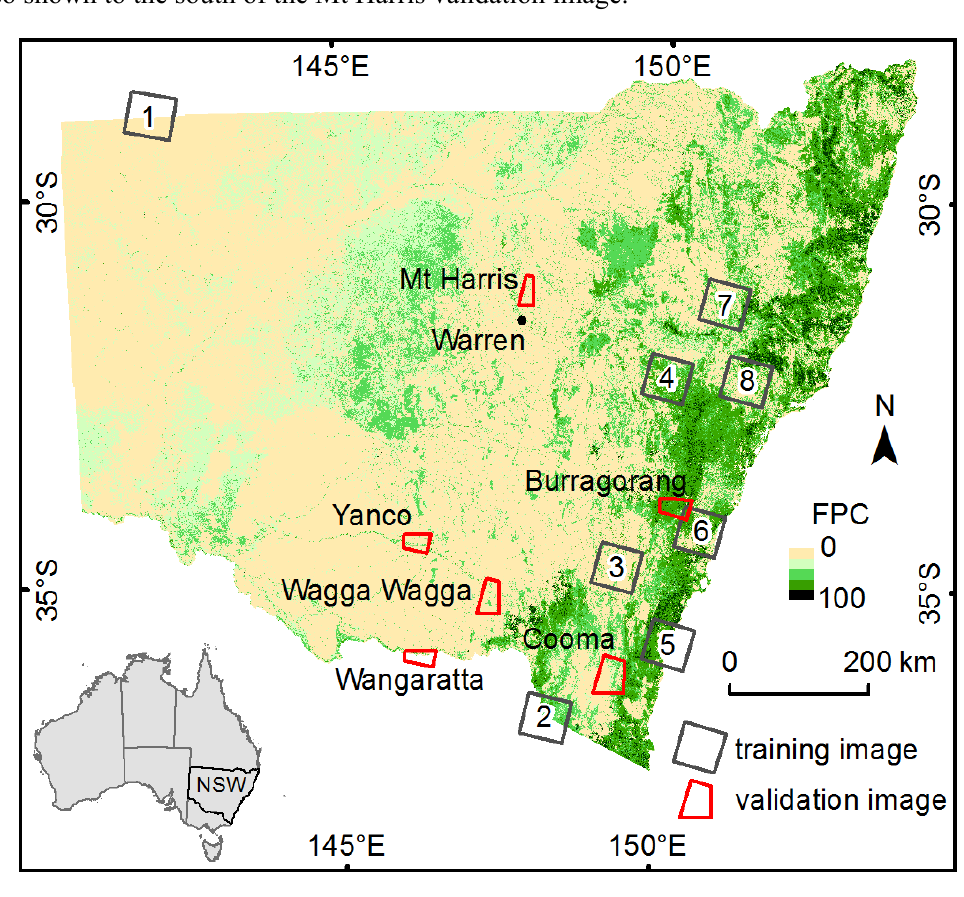
Figure 2. Location of the SPOT5 HRG images across New South Wales (NSW), Australia, used to train and validate the water classification, over Landsat TM/ETM+ derived foliage projective cover (FPC) [17]. The validation images are irregular shapes as they correspond to the areas of overlap between concurrent SPOT5 HRG data and high resolution imagery captured with a Leica Airborne Digital Sensor (ADS40). Greater FPC values correspond to the humid forests of the east coast, while the semi-arid and arid grasslands, shrublands and woodlands in the west have much lower FPC values. The location of the town of Warren is also shown to the south of the Mt Harris validation